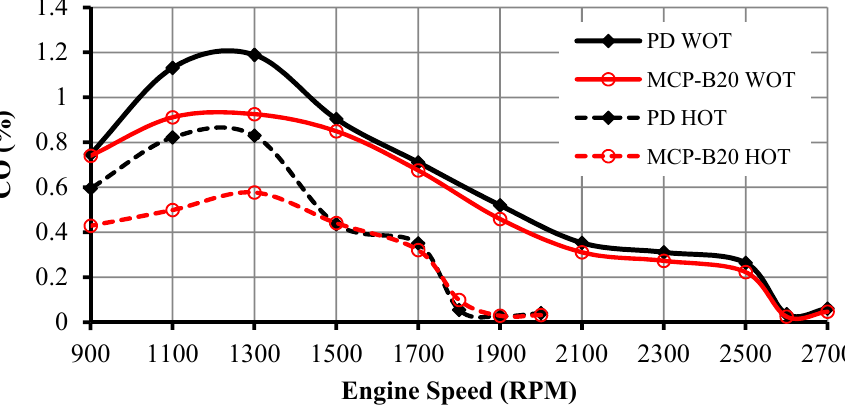
Figure 10. The relationship between tractor engine speeds (RPM) and CO (%) for PD and